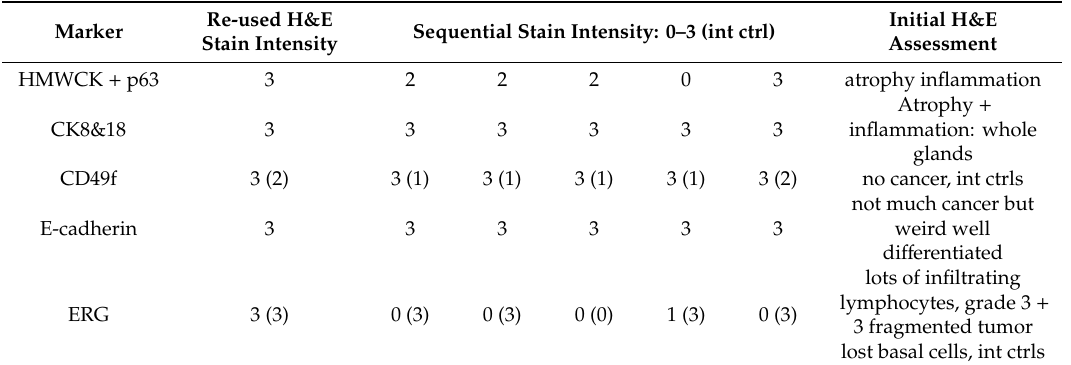
Table 4. Comparison of H&E re-used and sequential comparator immunostaining intensity scores. Re-used H&E Sequential Stain Intensity: 0–3 (int ctrl) Marker Stain Intensity